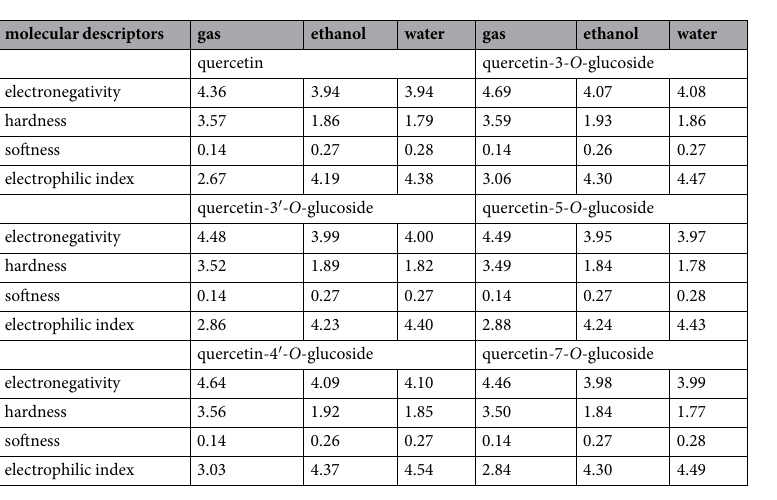
Table 1. Molecular descriptors calculated from the total energy method obtained at M062X/6–311 + G ** level of